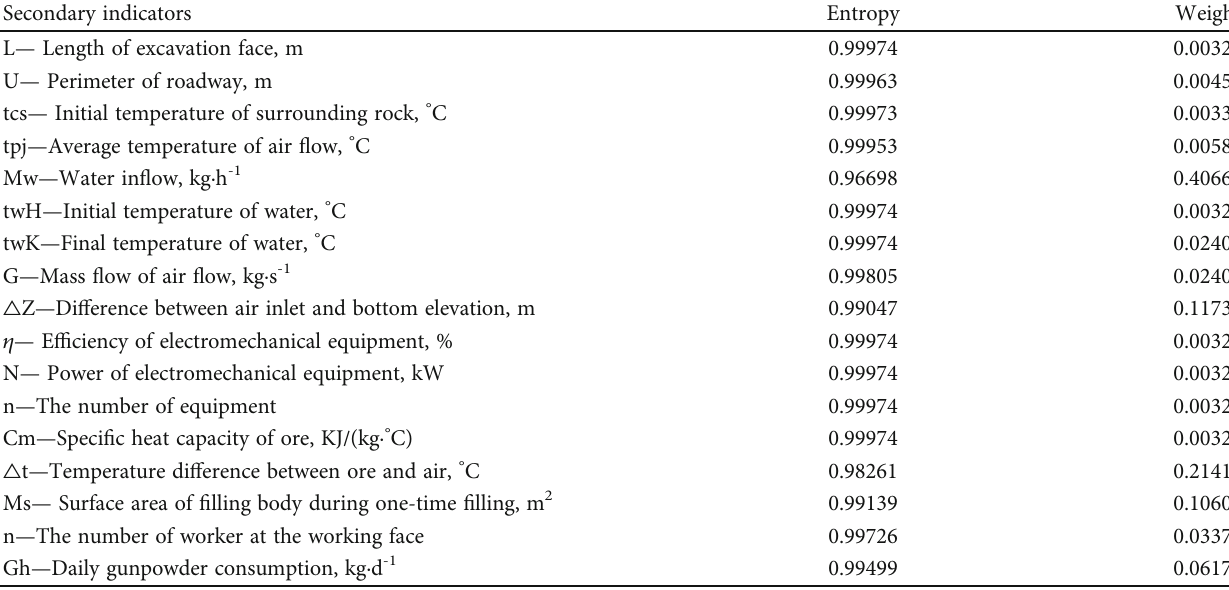
Table 7: Weight calculation and ranking of deep stope thermal environment